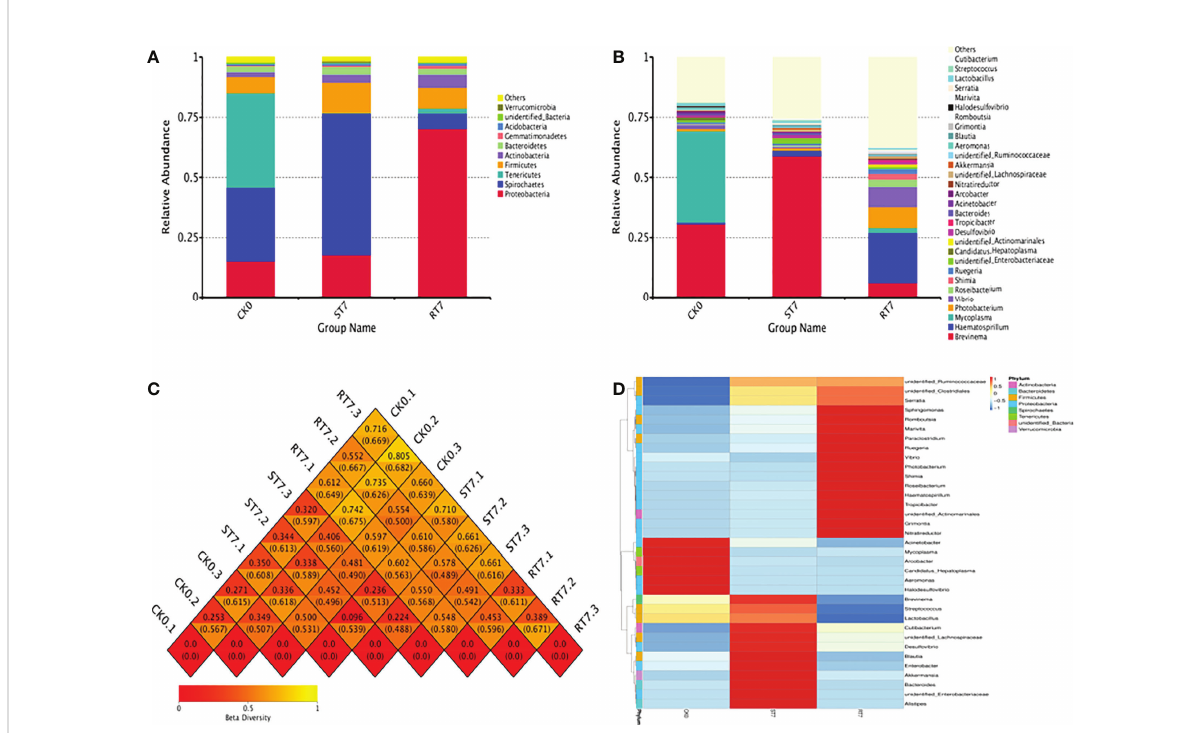
FIGURE 2 Alteration of intestine microbial structure. (A) Relative abundance of intestine microbial at phylum level. (B) Relative abundance of intestine microbial at genus level. (C) Heatmap of b -diversity. (D) Heatmap analysis of intestine